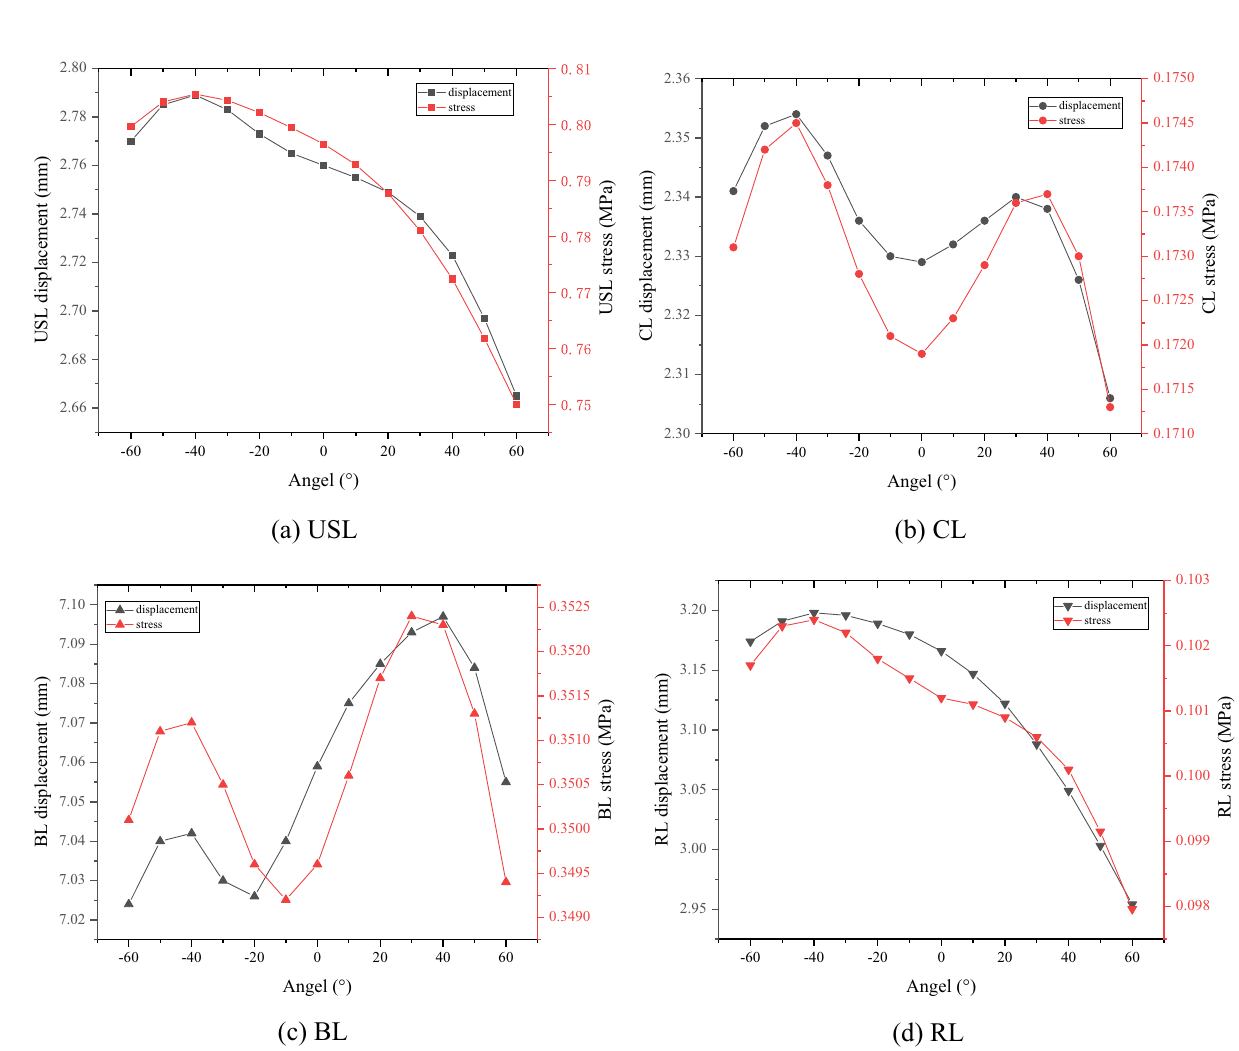
Figure 6. Changes of stress and displacement of uterine ligaments. a USL. b CL. c BL. d RL. (IAP = 10 kPa, created by OriginPro 2021, https:// www. origi nlab.